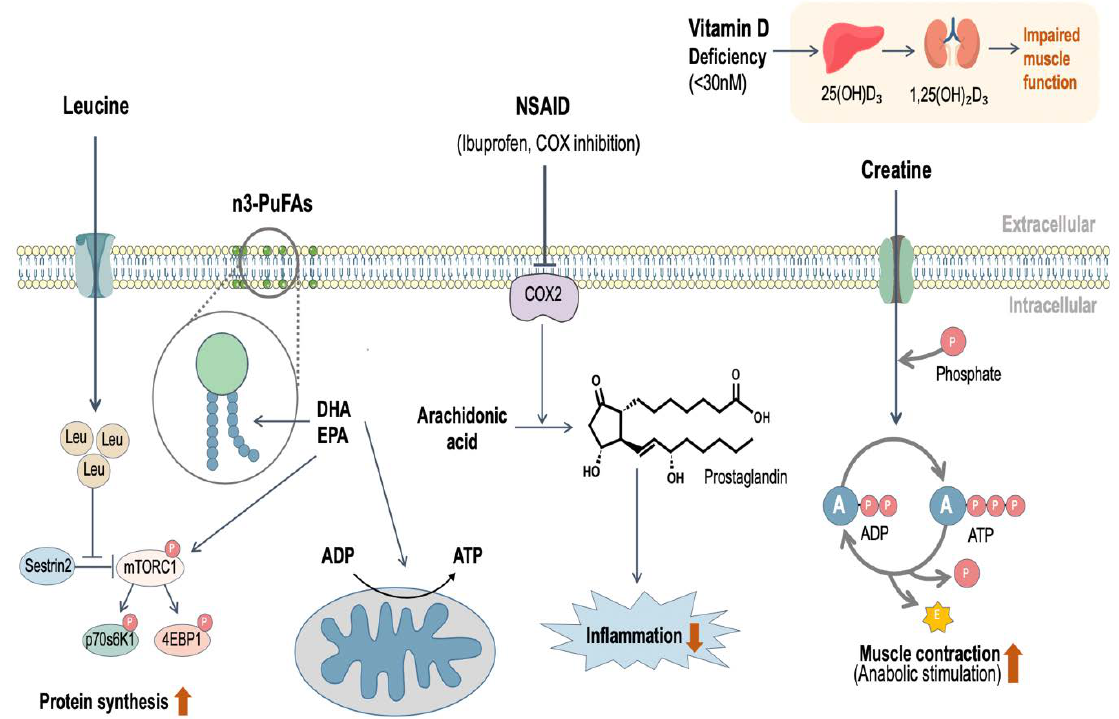
Figure 2. Schematic illustration of the mechanisms through which the nutritional supplements discussed in the present review may function to promote skeletal muscle adaptation. Leucine has been shown to independently activate the mammalian target of rapamycin (mTOR) signaling pathway through binding to Sestrin2, which increases protein synthesis. Omega-3 polyunsaturated fatty acids (n3-PUFA)—especially eicosapentaenoic acid (EPA) and docosahexaenoic acid (DHA)—serve as a component of phospholipids in muscle membranes, and not only enhance protein kinase activity, but also improve mitochondrial respiratory sensitivity to ADP. Vitamin D is metabolized to the active form, 1,25(OH) 2 D 3 , via the liver and kidney, and vitamin D deficiency is associated with impaired skeletal muscle function. Creatine has been shown to enhance resistance exercise performance, which stimulates anabolism through its integral role in the phosphocreatine energy system. Non-steroidal anti-inflammatory drugs (NSAID) reduce inflammation and oxidative stress, which may contribute to muscle loss in older adults. ADP, adenosine di-phosphate; ATP, adenosine tri-phosphate; A, adenosine; P, phosphate; E, energy; COX, cyclo-oxygenase; Leu, leucine; 4EBP1, eukaryotic initiation factor 4E binding protein 1.